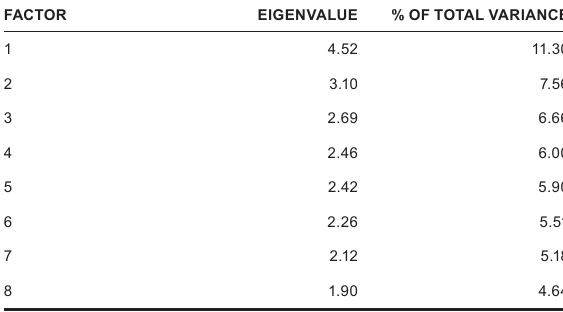
Table 2 Factor analysis: Validity of the instrument measuring managerial